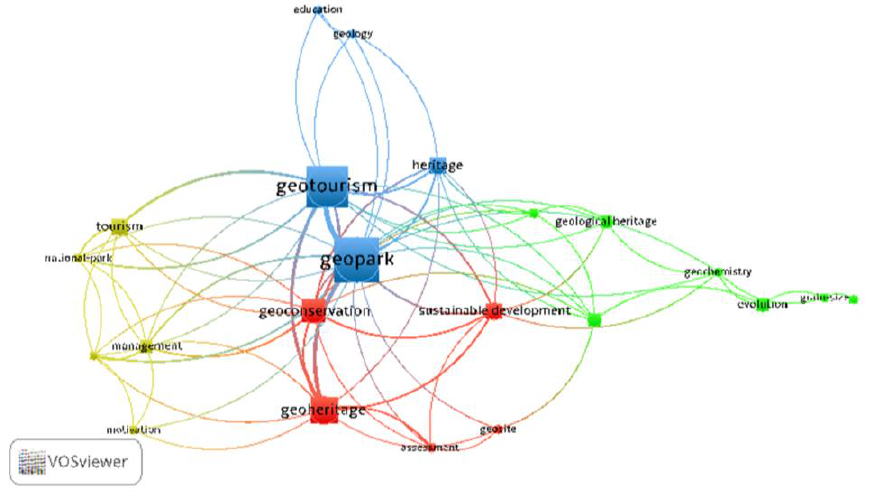
Figure 4. Co-occurrence network of the high-frequently used keywords. Source: own elaboration in VosViewer.